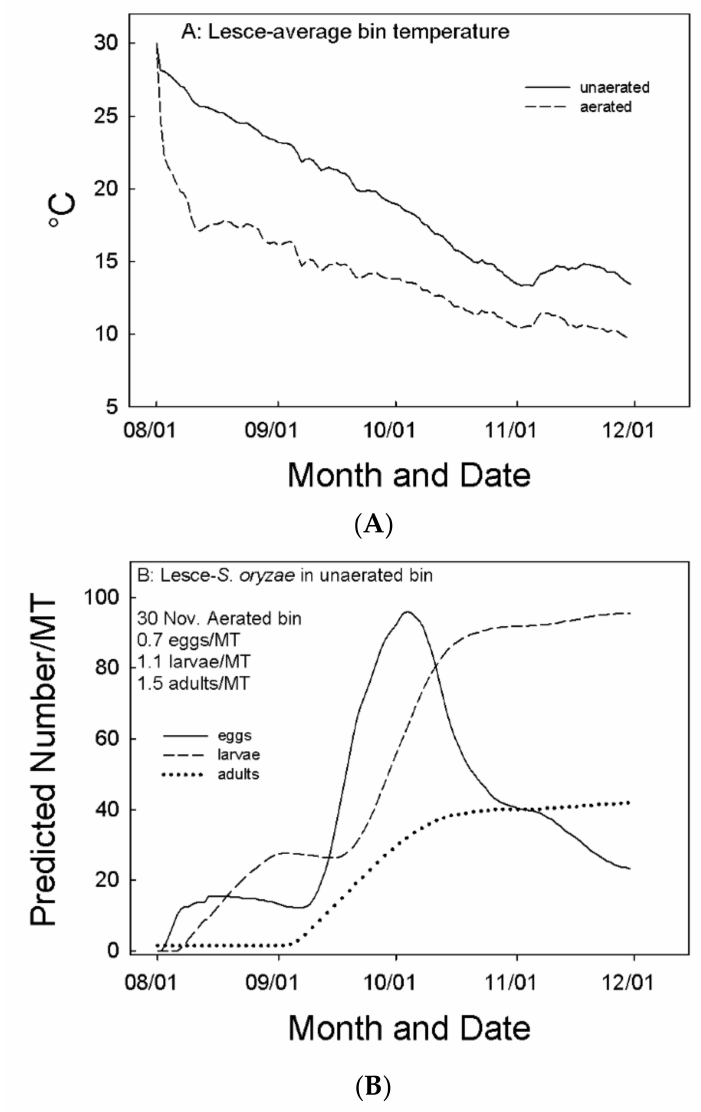
Figure 4. Predicted average bin temperatures in unaerated and aerated wheat stored in Lesce, Slovenia from 1 August to 30 November ( A ); and predicted numbers of eggs, larvae, and adults of Sitophilus oryzae in unaerated wheat ( B ). Predicted numbers of each life stage on November 30 in aerated wheat are listed as text ( B ). In the X-axes, date is given in Month-Day